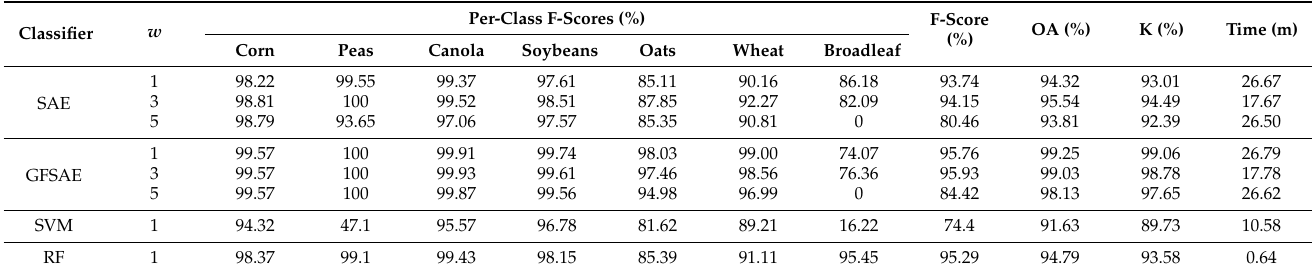
Table 5. Accuracy metrics and training time obtained on the Winnipeg